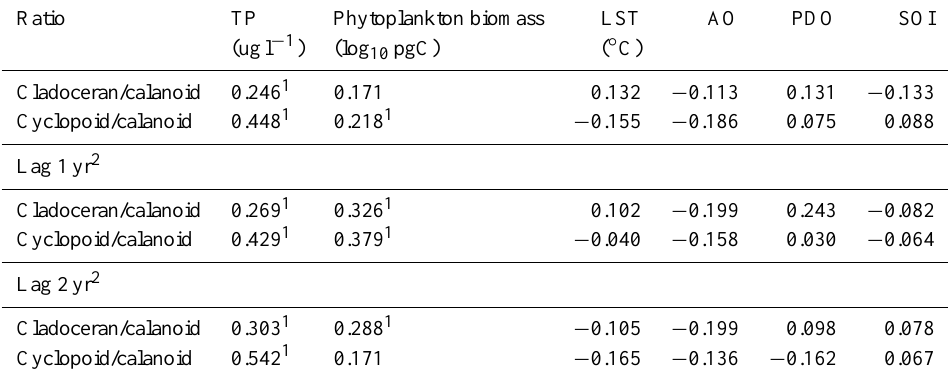
Table 3. Results of correlation analyses of the zooplankton group ratio versus environmental variables.